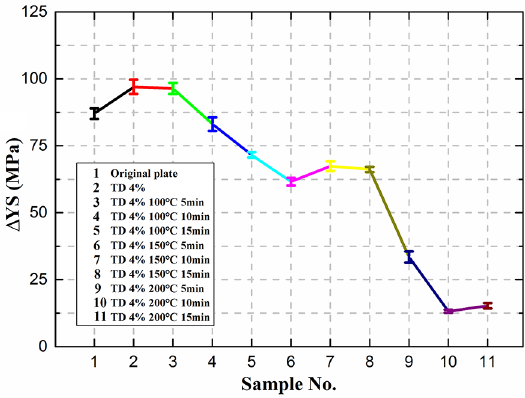
Figure 7. The variation trend of ∆YS under different conditions.